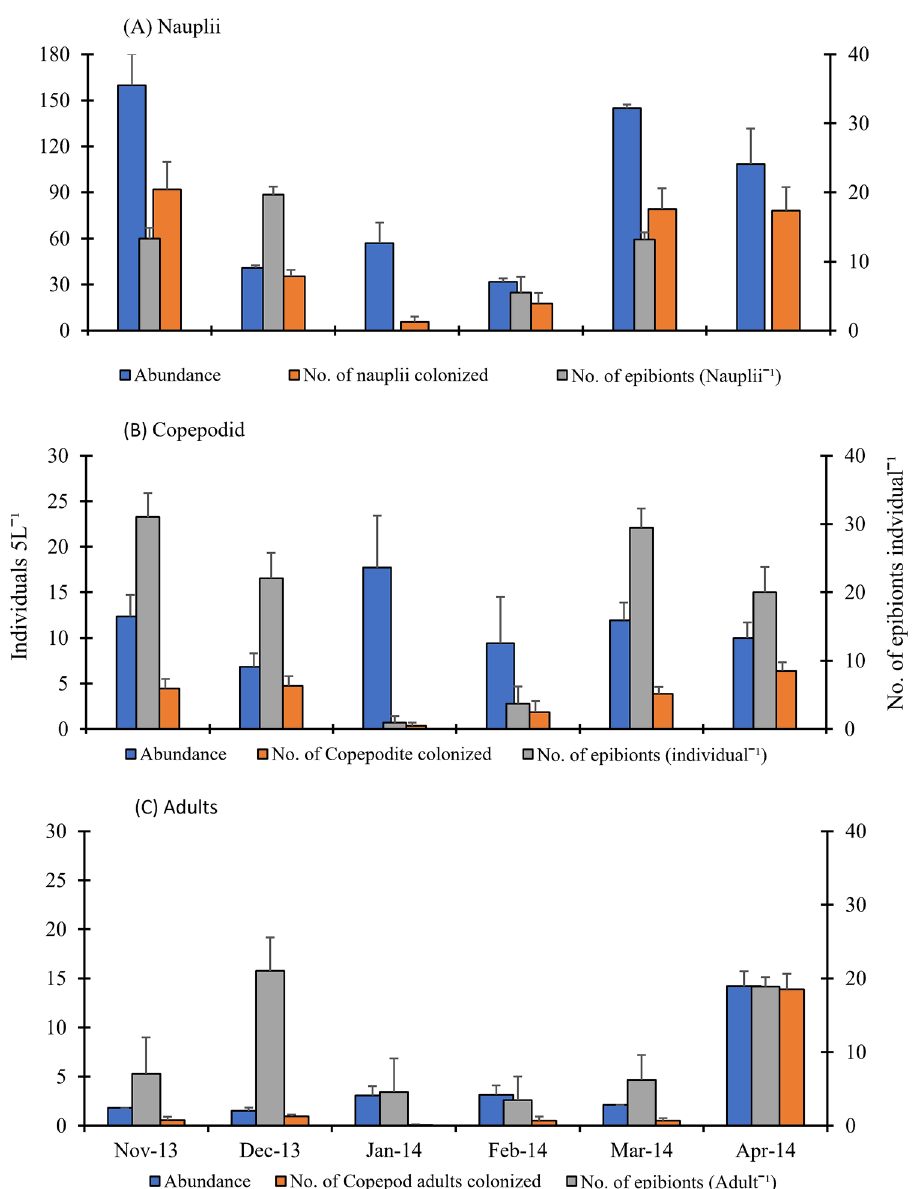
Figure 4. Monthly average of abundance (Individuals 5L −1 ) and infestation load (No. of epibiont individual −1 ) of ovigerous and non-ovigerous copepods, Mesocyclops ( A ) nauplii, ( B ) copepodid and ( C ) adults during November 2013 to April 2014, from the flood plain wetland of the river